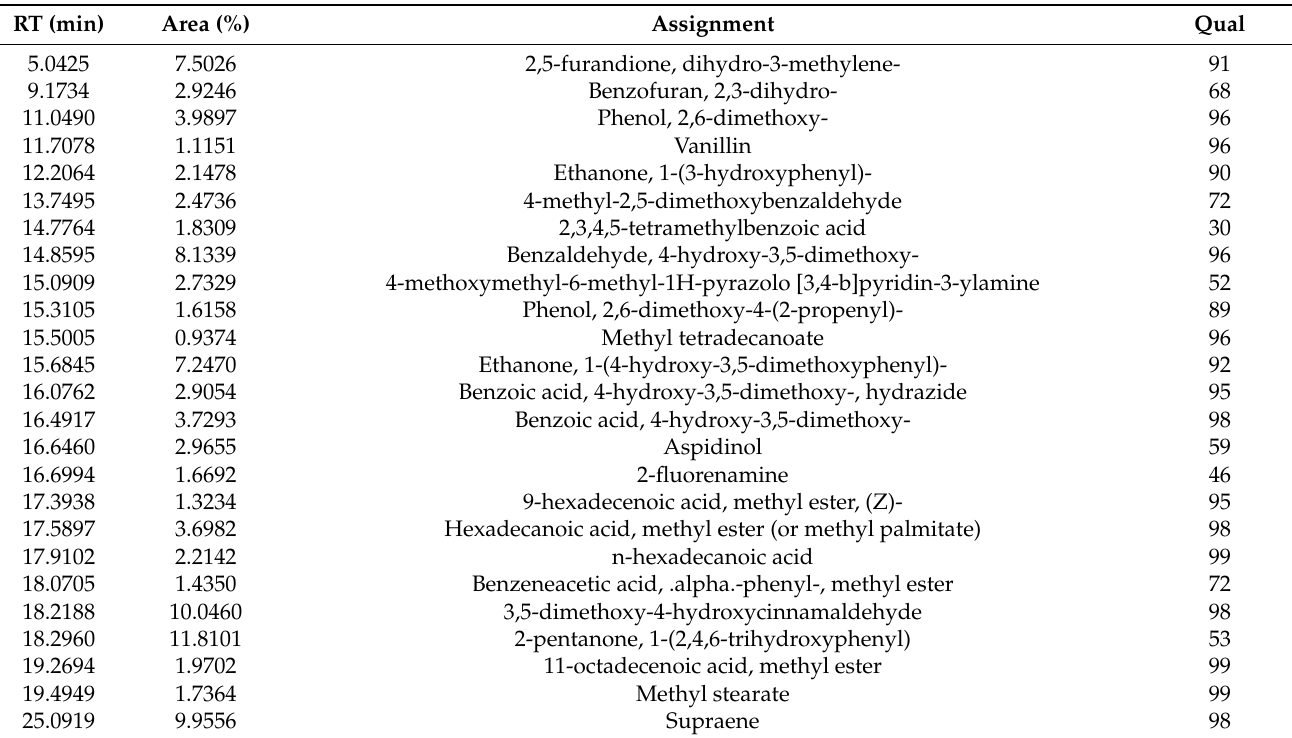
Table 2. Major phytochemical compounds identified in the aqueous ammonia extract of T. gallica bark by GC −